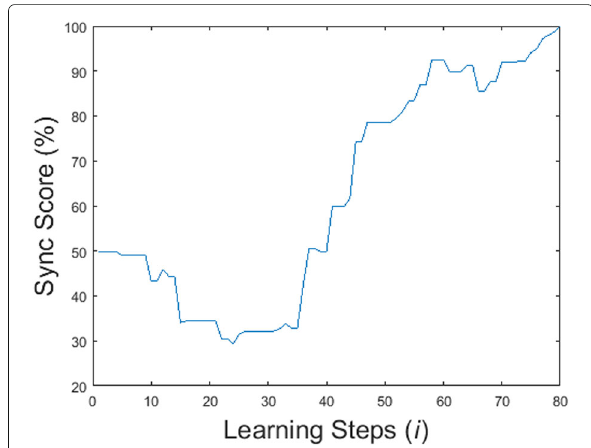
Fig. 10 Final synchronization score. Synchronization score determining matching weights from session key